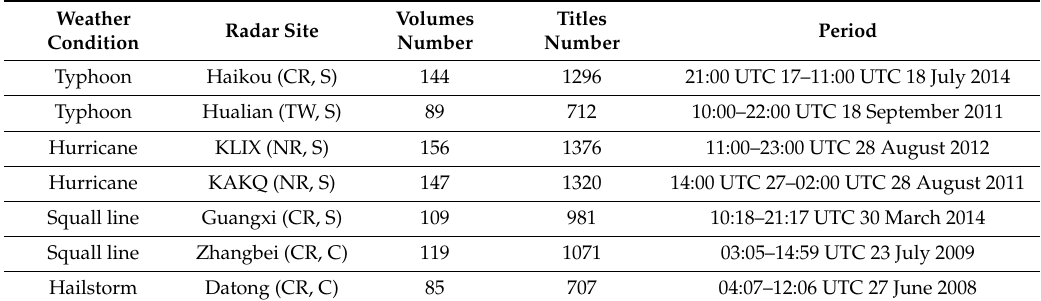
Table 1. Summary of the seven study cases. (CR: China radar network (CINRAD), TW: TaiWai,